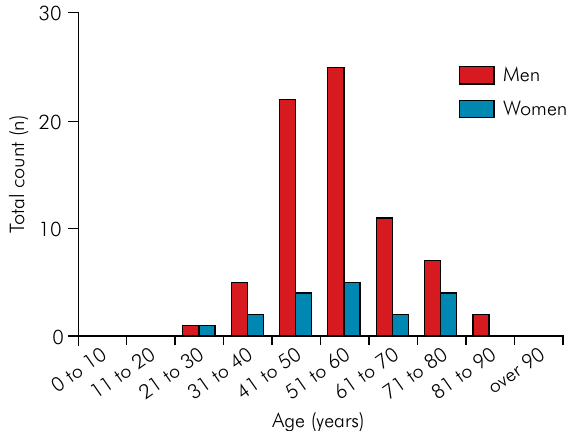
Figure 2. Distribution of potentially malignant and malignant lesions (n = 103) according to age and